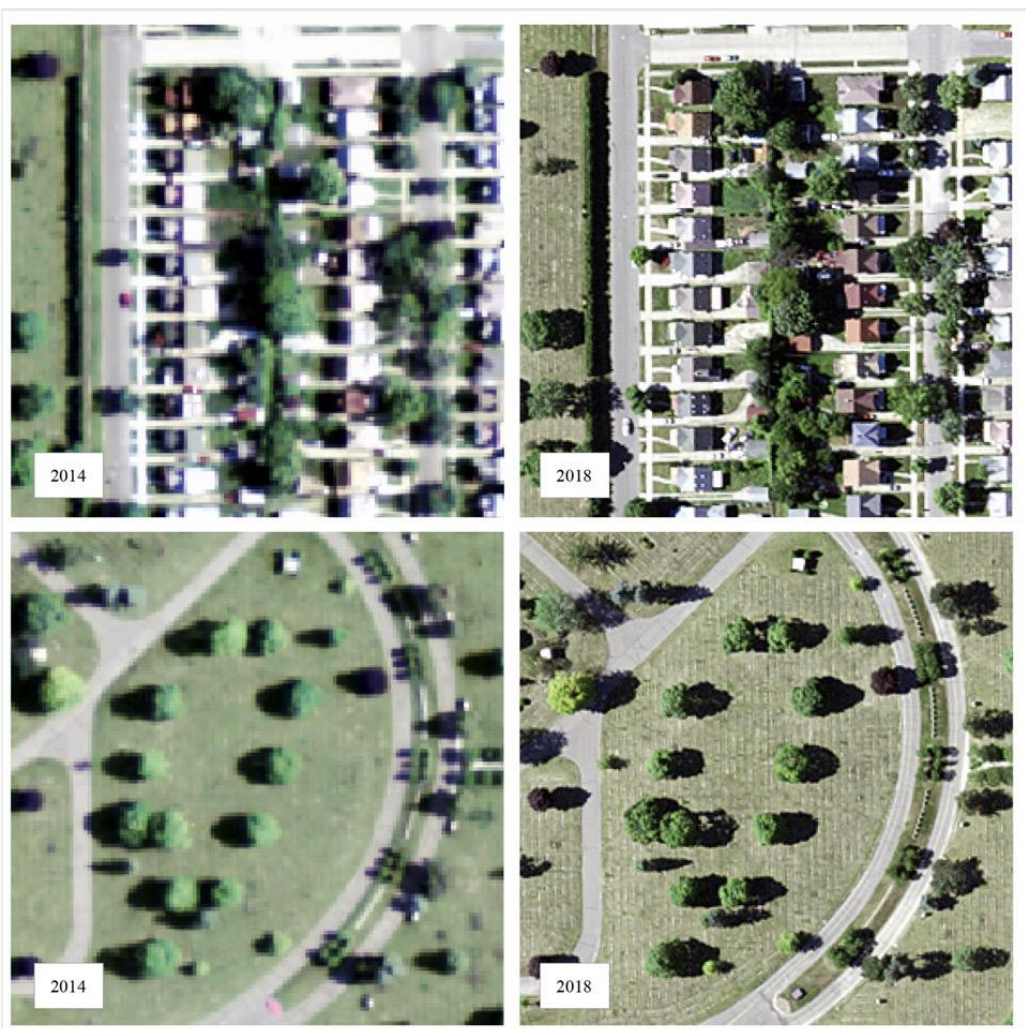
Figure 5. NAIP imagery, opposing direction of shadows.